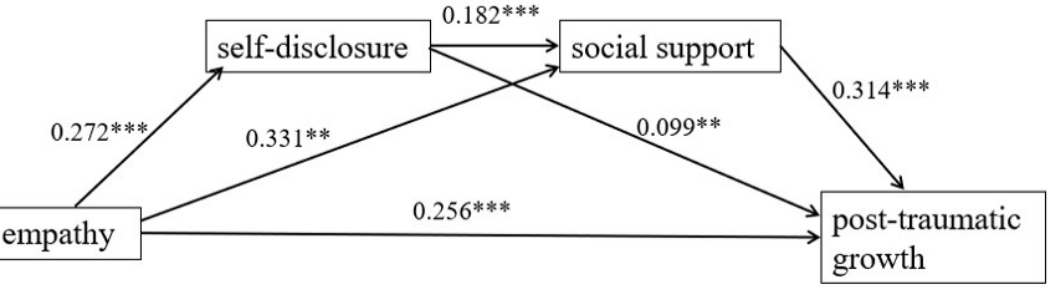
Figure 2. Mediating model of self-disclosure and social support on empathy and post-traumatic